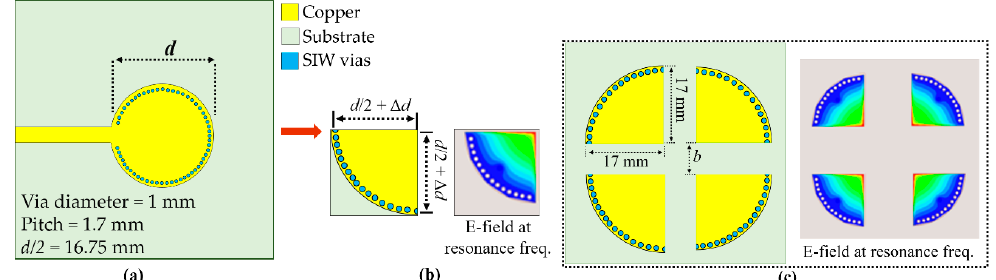
Figure 1. Proposed 4-port quarter-mode substrate-integrated waveguide (QMSIW) cavity resonator developed from the circular full substrate-integrated waveguide (SIW) cavity resonator: ( a ) microstrip